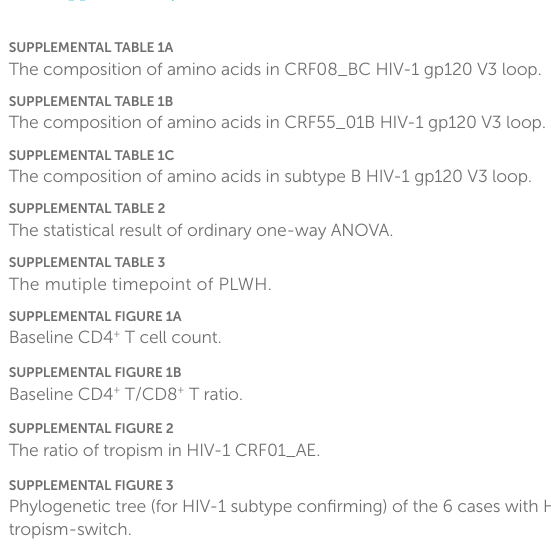
SUPPLEMENTAL TABLE 2 The statistical result of ordinary one-way ANOVA. SUPPLEMENTAL TABLE 3 The mutiple timepoint of PLWH. SUPPLEMENTAL FIGURE 1A Baseline CD4 + T cell count. SUPPLEMENTAL FIGURE 1B Baseline CD4 + T/CD8 + T ratio. SUPPLEMENTAL FIGURE 2 The ratio of tropism in HIV-1 CRF01_AE. SUPPLEMENTAL FIGURE 3 Phylogenetic tree (for HIV-1 subtype confirming) of the 6 cases with HIV-1 tropism-switch.